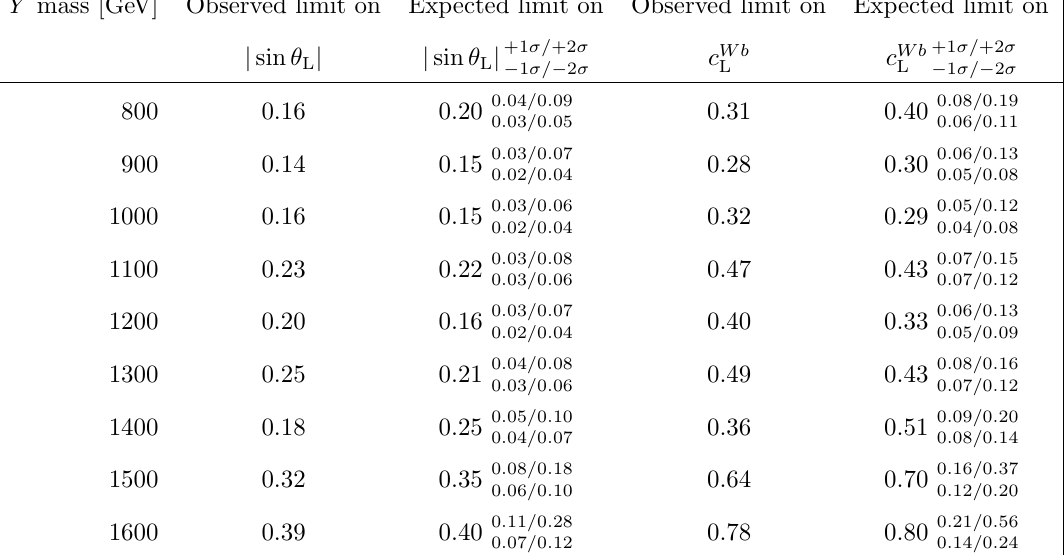
Table 7. Observed and expected 95% CL upper limits on Y quark in a ( T; B; Y ) triplet model with masses of 800 GeV to 1600 GeV. The uncertainties in the expected limits are also